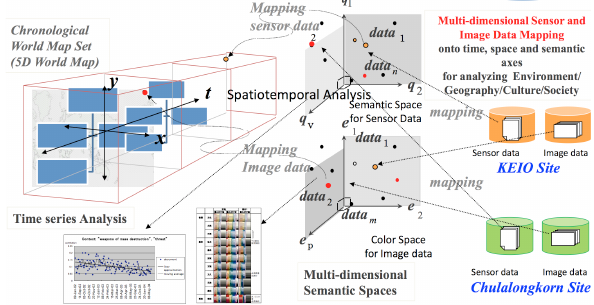
Figure 4. The base architecture of 5D world